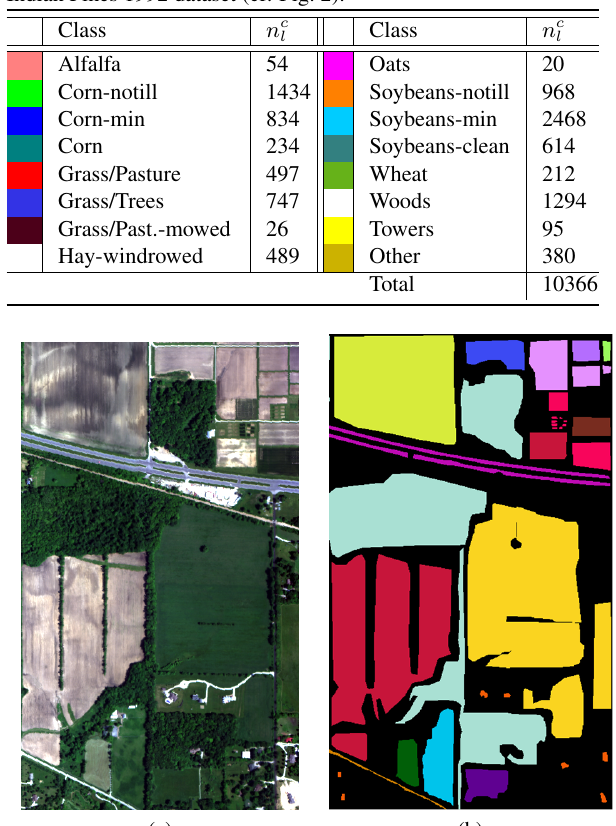
) of the ground truth of the l